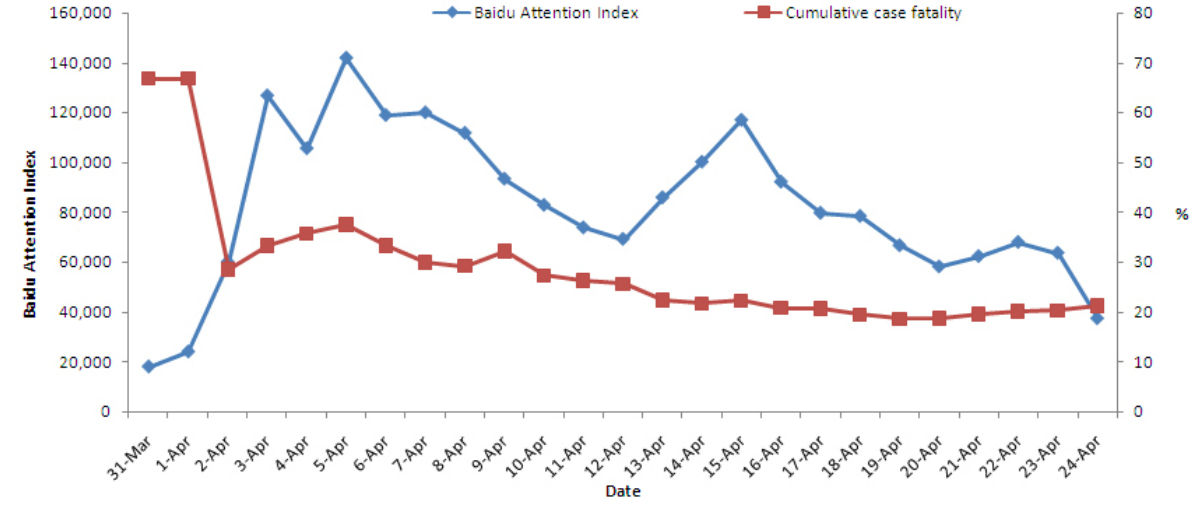
Figure 6. The daily Baidu Attention Index (BAI) of H7N9 discussion trends on Baidu website positively associated with cumulative case fatality rate of human H7N9 infection in China from March 31 to April 24,